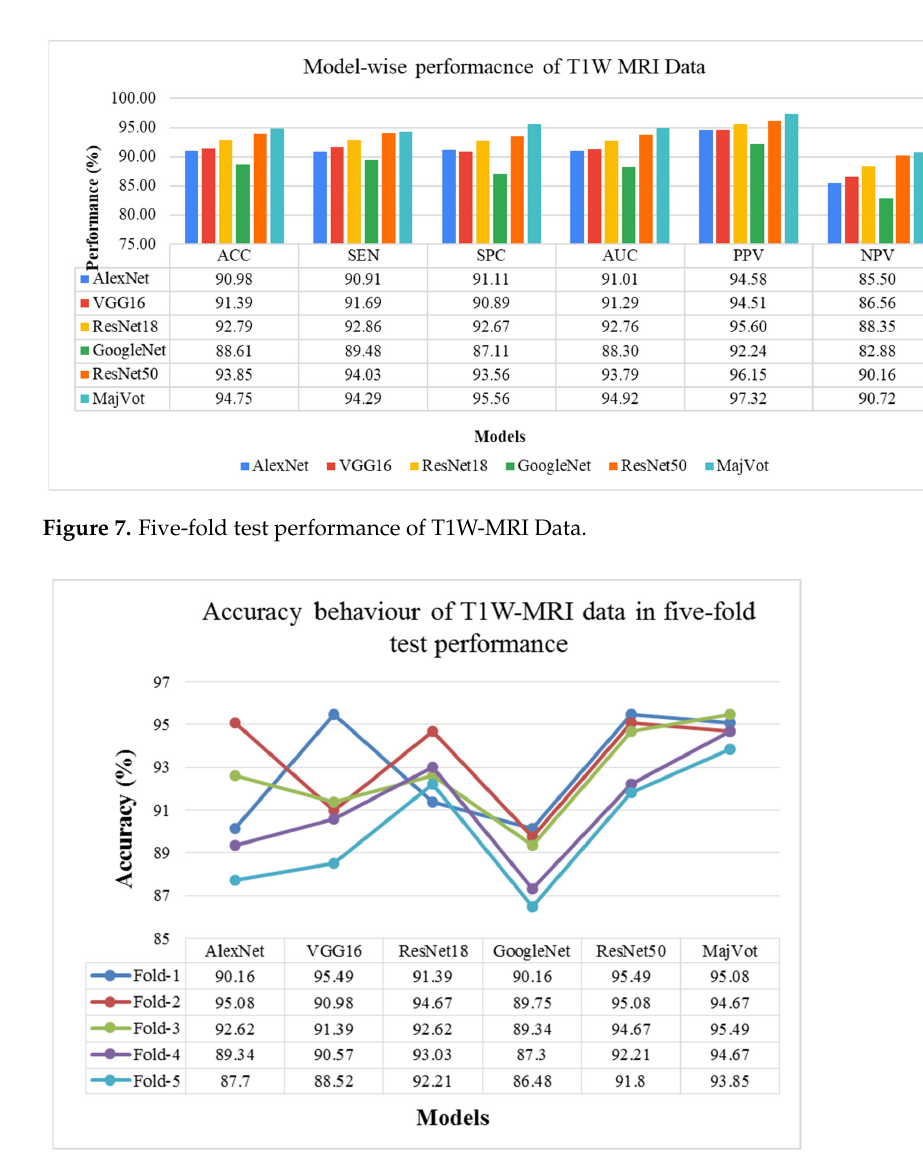
Figure 8. Model-wise accuracy behavior in the five-fold test performance of T1W-MRI data.